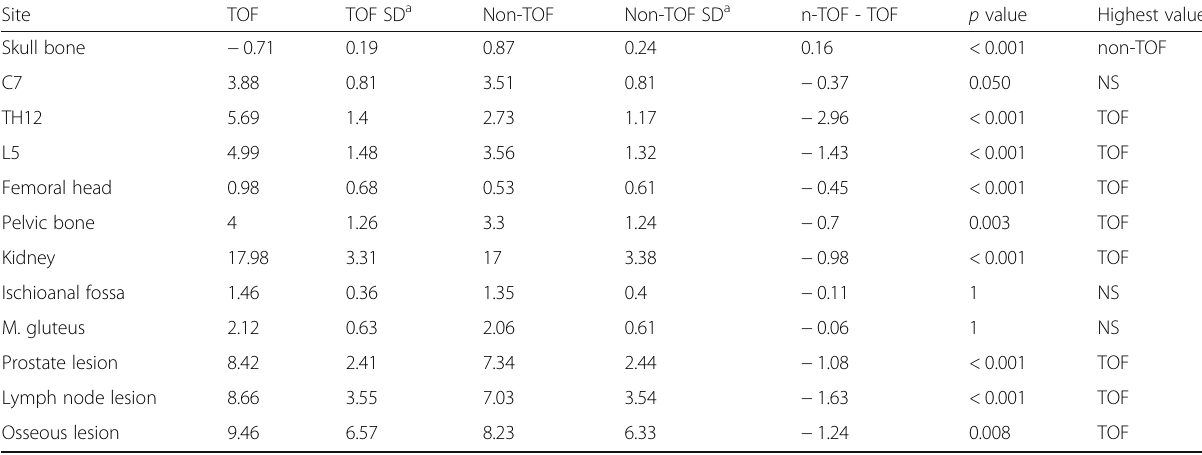
Table 4 Average SUV max and SUV max difference (difference significant if p <